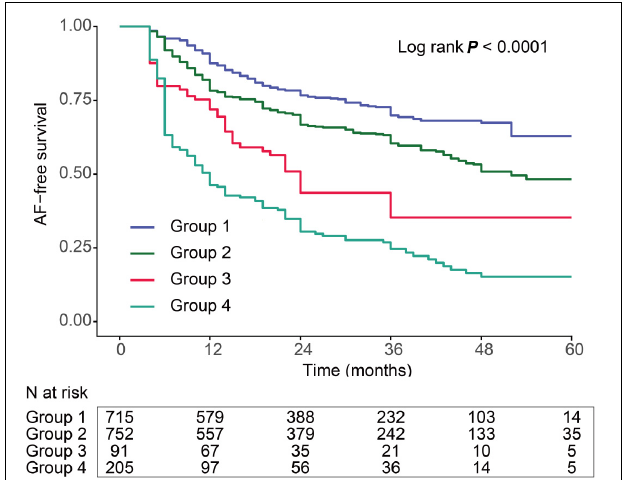
FIGURE 3 | Kaplan–Meier curve showing the incidence of recurrence. All patients were divided into four categories. The lines represent the following: group 1: patients with both short AF duration and no ER (blue); group 2: patients with LAFD and no ER (green); group 3: patients with short AF duration and ER (red); and group 4: patients with both LAFD and ER (light green).